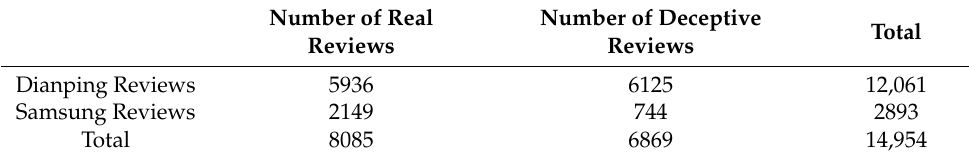
Table 4. Real and deceptive reviews from the Dianping and Samsung case.